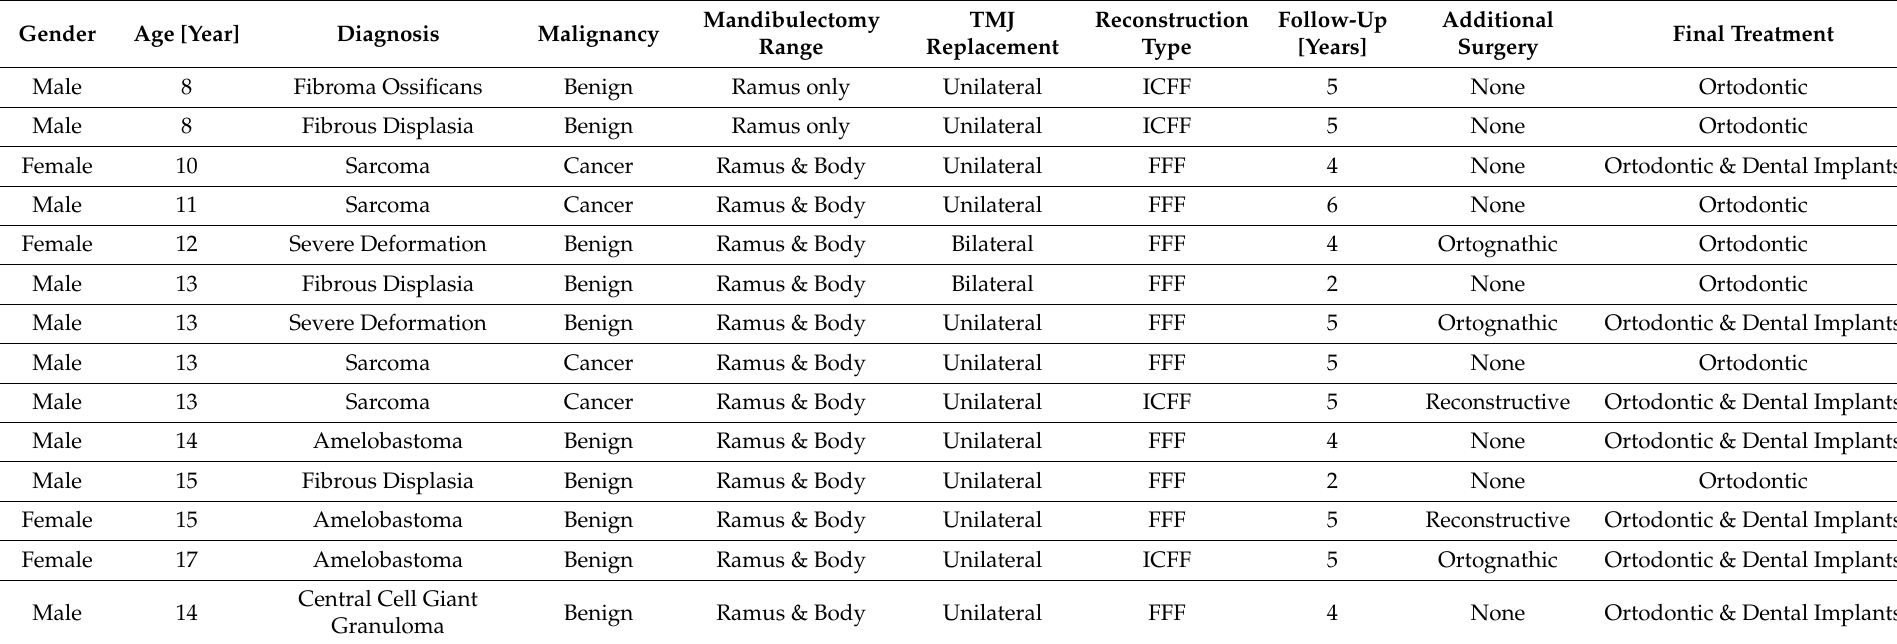
Table 1. Summary of patients enrolled in the study, including: diagnosis, level of malignancy, resection extent, and reconstruction type. Additional surgery performed after the follow-up (2–6 years postoperative): none—orthodontic treatment and implant placement were performed with use of a primary graft after the follow-up; reconstructive—orthodontic treatment and implant placement required secondary bone grafting; orthognathic—additional orthognathic surgery was required in order to treat skeletal deformation at the time of the TMJR surgery or after the